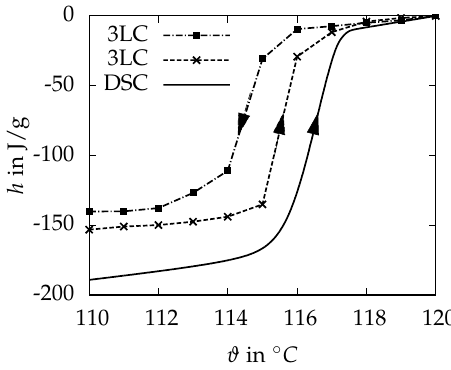
Figure 7: Enthalpy h as a function of the temperature ϑ for Figure 8: Thermal diffusivity a of the investigated PCM. The Figure 6. Enthalpy h as a function of the temperature ϑ for MCHH. The solid line is the result of the MCHH. The solid line is the result of the DSC mea- error bars are the standard deviation from three dif- surement (Figure 6) and the dashed lines connect the ferent samples and five shots at each temperature. DSC measurement (Figure 5) and the dashed lines connect the resulting measuring points from the resulting measuring points from the 3LC. The arrows The dashed line represents the linear fit of the points, 3LC. The arrows indicate the direction of temperature change within the indicate the direction of temperature change within used to calculate the temperature dependency of a, the measurements. and extrapolated to the melting point of the PCM.